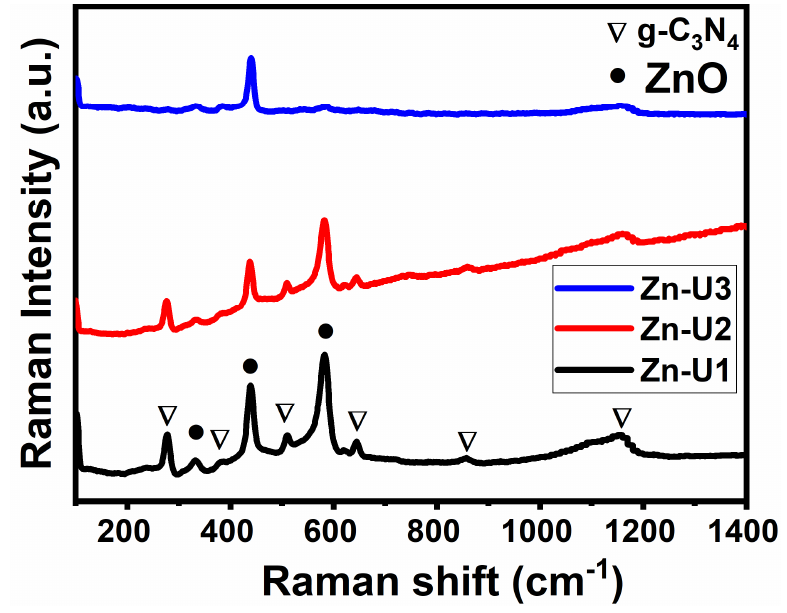
Figure 3. Raman spectra of the Zn-U1, Zn-U2, and Zn-U3 nanocomposites.